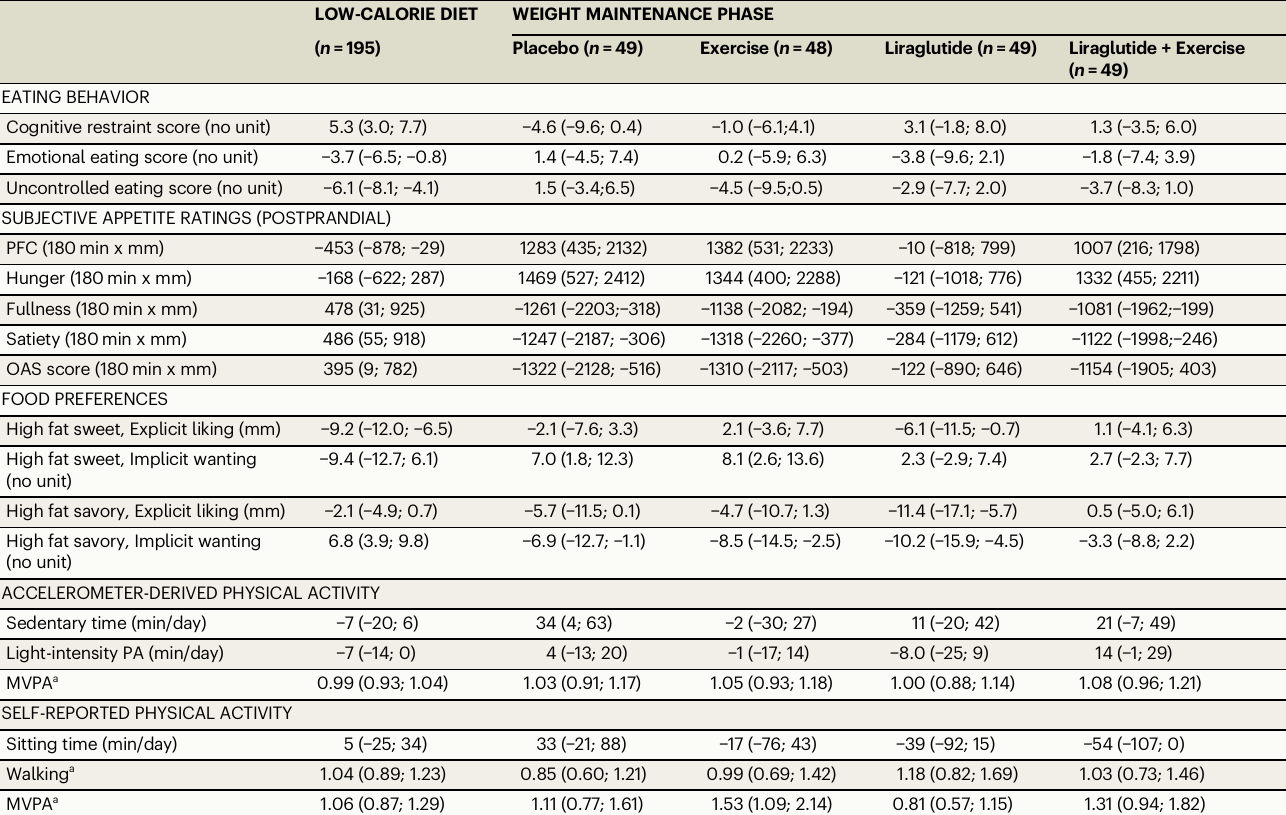
Table 4 | Changes in outcomes during low-calorie diet and weight loss maintenance by intervention group in the intention-to- treat population LOW-CALORIE DIET WEIGHT MAINTENANCE